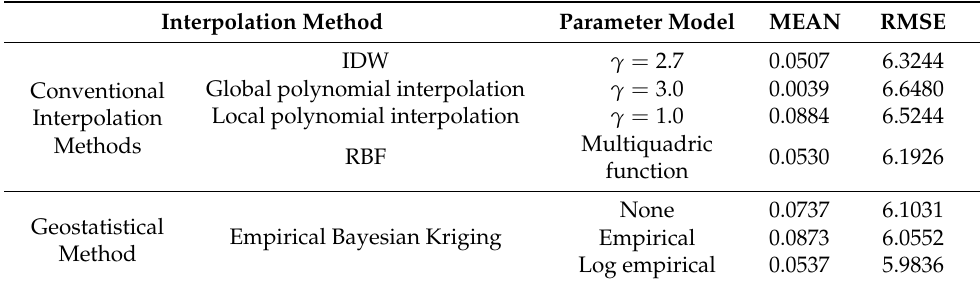
Table 4. Comparison of different interpolation